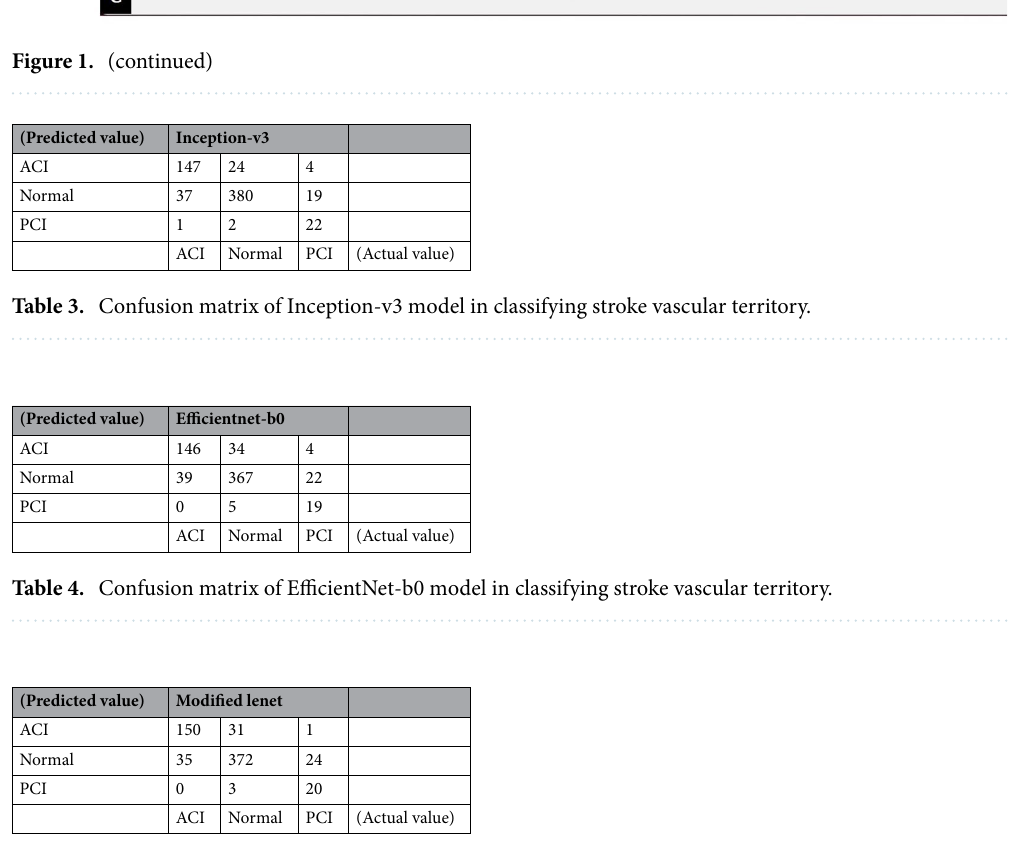
Table 5. Confusion matrix of Modified LeNet model in classifying stroke vascular